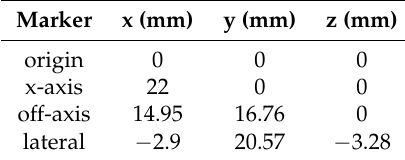
Table 1. Coordinates of the IMU rigid body markers to align with the Qualisys L-shaped reference.